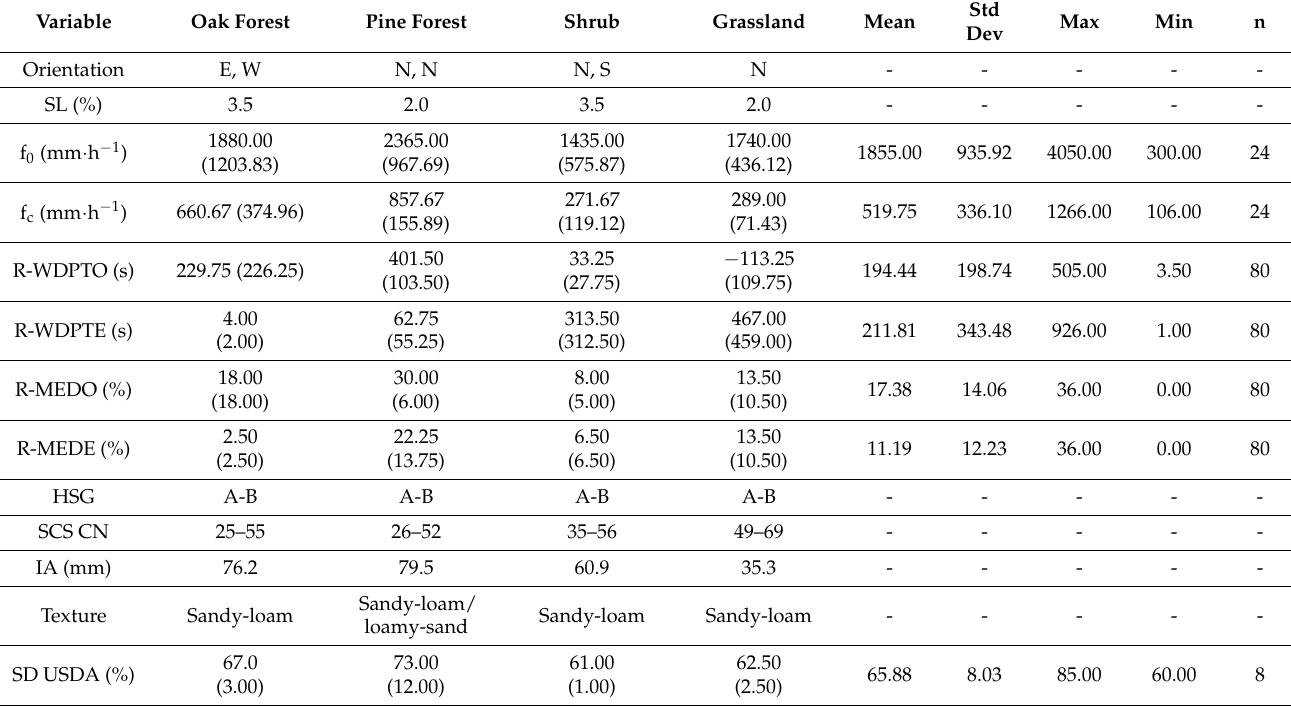
Table 1. Study variables for the four types of vegetation. Mean and (standard deviation). Soil properties for 0 to 50 cm